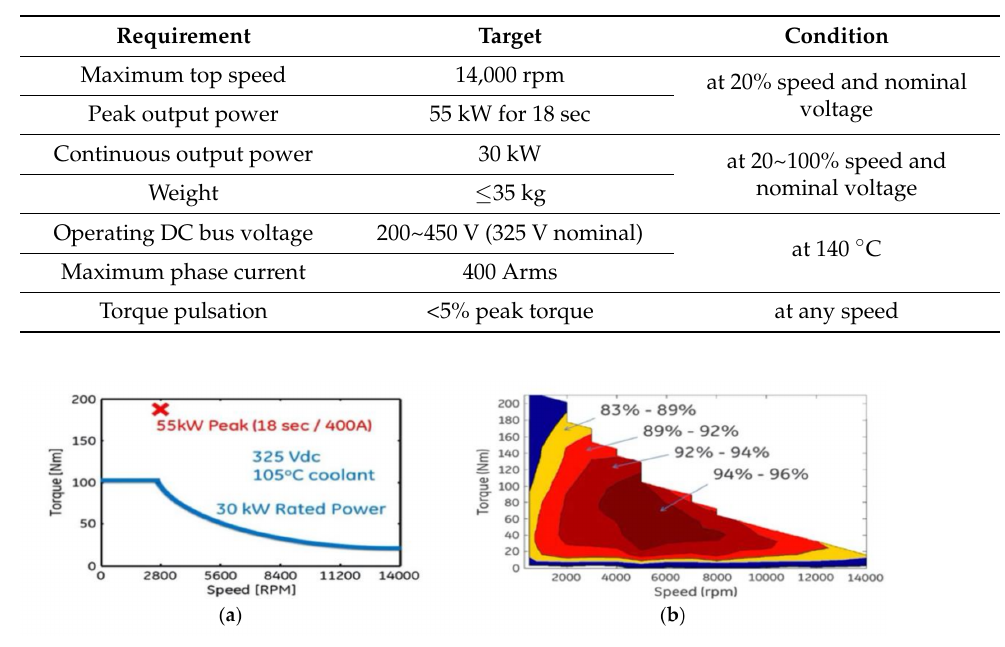
Table 8. FreedomCar 2020 machine specification.